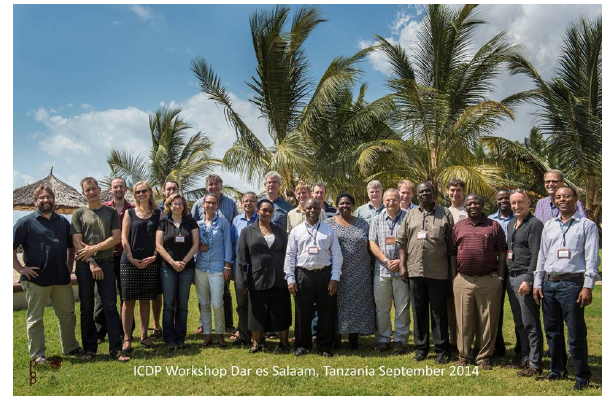
Figure 3. The workshop participants. Photo: Ishka Michoka, Plas- tic Buddha